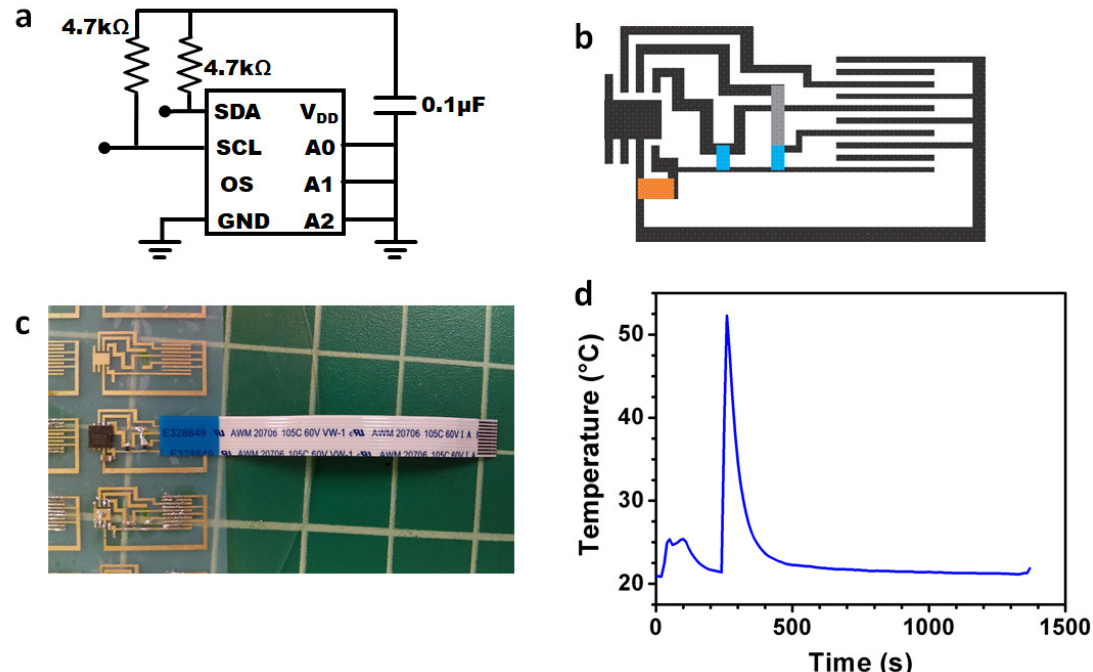
Figure 4. ( a ) Circuit diagram of the temperature sensing device. ( b ) Circuit board layout of the temperature sensing device with blue as the resistors, orange as the capacitor, and grey as the bridging connection. ( c ) Completed temperature sensor on nanocellulose. ( d ) Temperature output of the sensor tested over a period of time, first increase in temperature was due to contact with a finger touching the device, and the second increase was when the device was placed on the hotplate, and the hotplate turned off and left to cool.